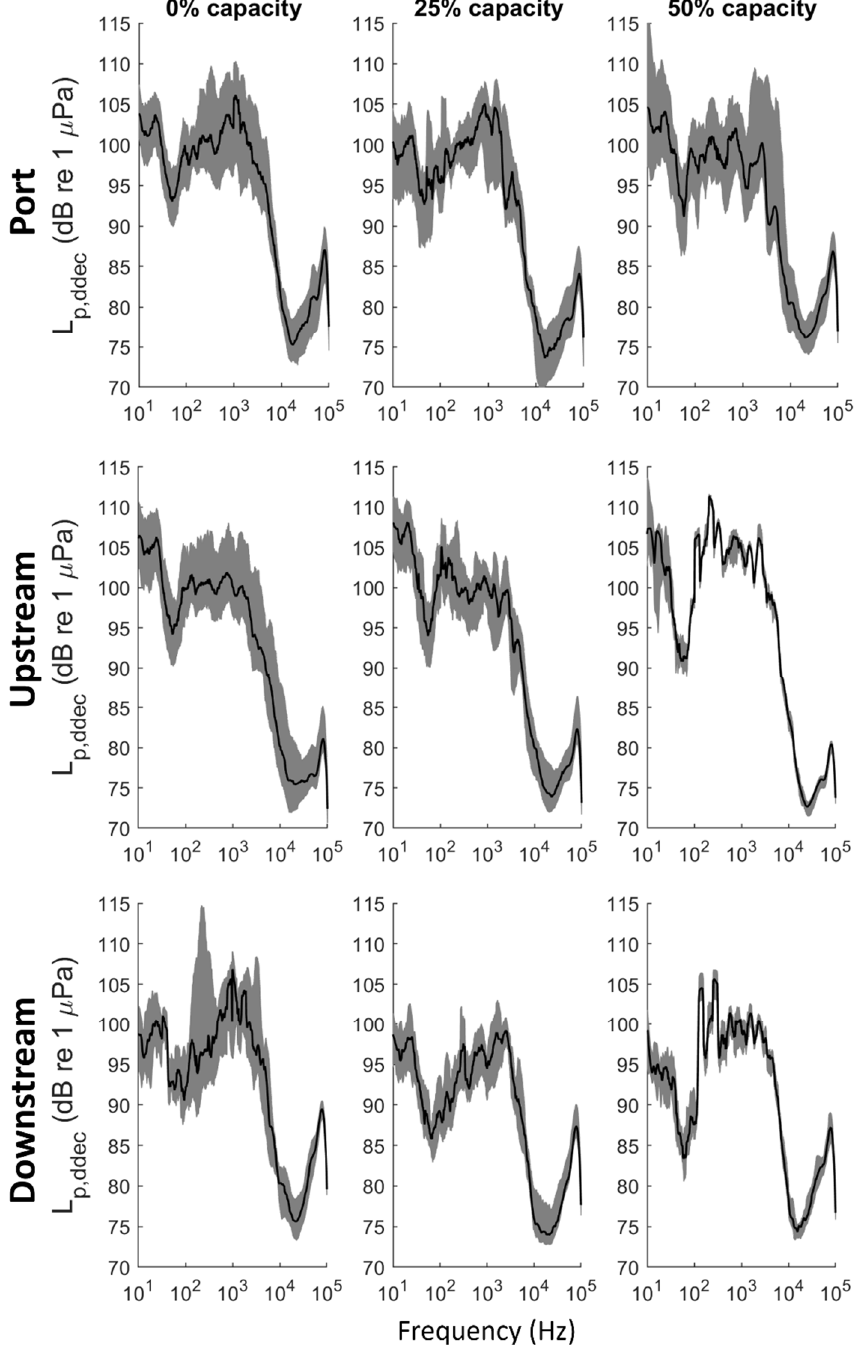
Figure 7. Median values (black curves) and interquartile range (gray shadow) of the decidecade sound pressure levels at five rated capacity levels in three 25 m × 25 m zones: in the upstream ( first row ), downstream ( second row ), and port ( third row ) directions from the turbine (see Figure 7). The frequency axis labels denote the lower limit of each decidecade frequency band. There are no acoustic measurements from the 75% and 100% turbine power generations states, which occurred during the stronger ebb tide of the day in the dark hours before sunrise.